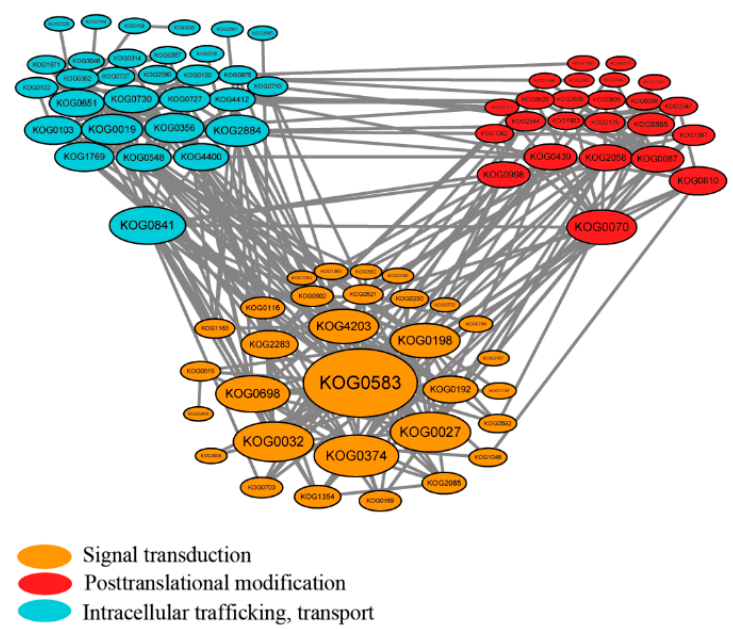
Figure 7. Protein-protein interaction (PPI) network of signal transduction, posttranslational modification and intracellular trafficking, transport related phosphoproteins by STRING. Nodes with orange, red and blue background color represent the KOGs of differential phosphoproteins related with signal transduction, posttranslational modification and intracellular trafficking, transport, respectively.